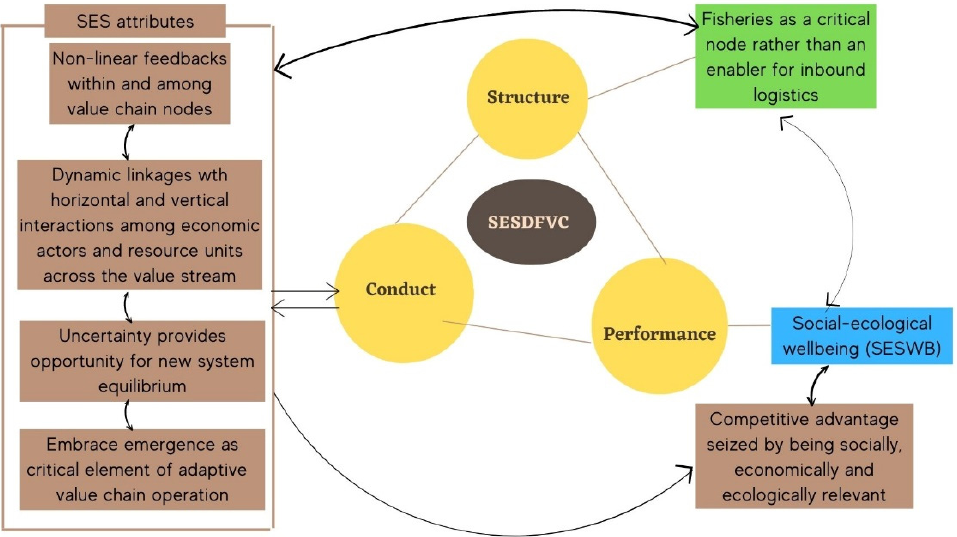
Figure 9. Mapping interactions of SES attributes in SES dried fish value chain having fisheries re- resource as critical value chain source as critical value chain node.